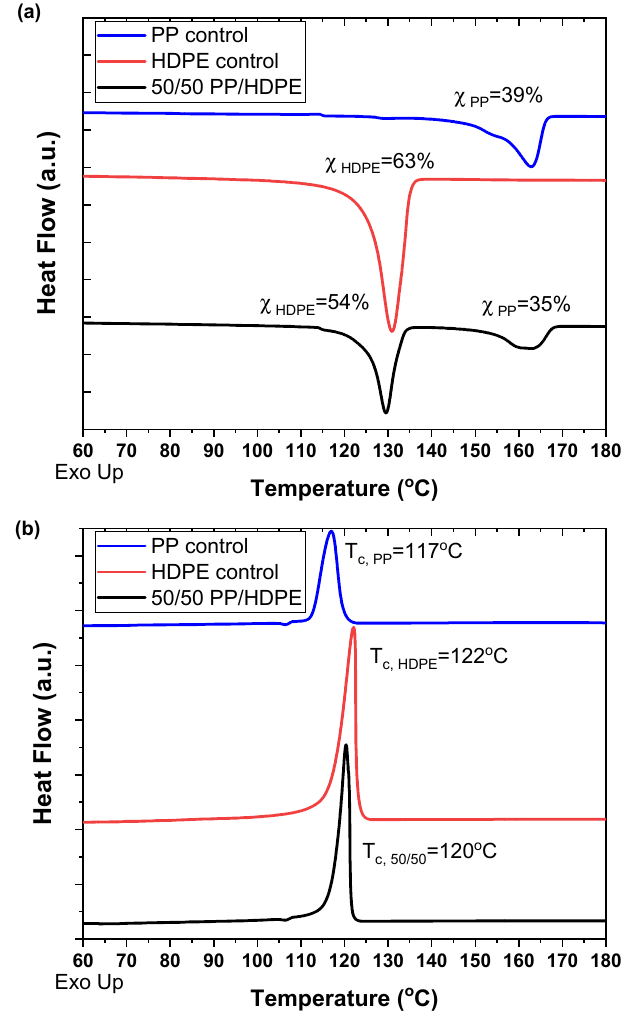
Figure 3. DSC thermographs of unoriented PP control tape, HDPE control tape, and 50/50 PP/HDPE tape; ( a ) heating curve indicating melting peaks; ( b ) cooling curve indicating crystallization peaks.